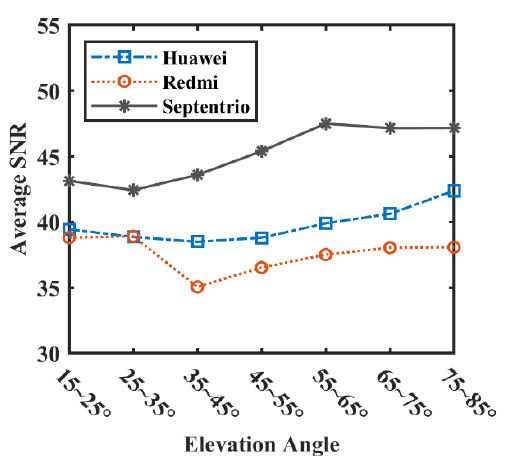
Figure 4. Average SNR for different angles of altitude.